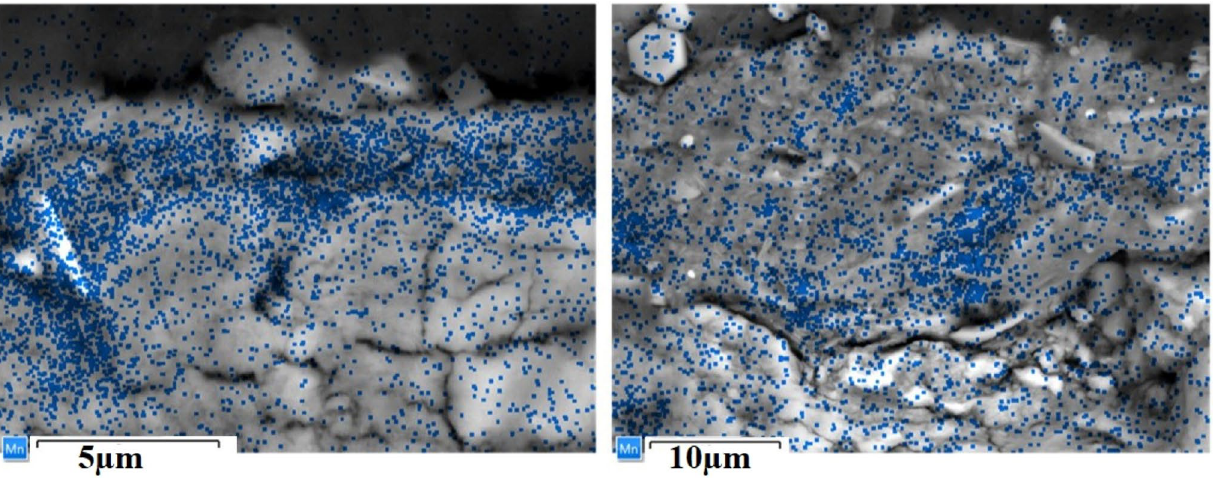
Fig. 5 Non-irradiated bone cross-section observed under FE-SEM and the corresponding EDS map analysis for Mn (2 different areas of inter- est